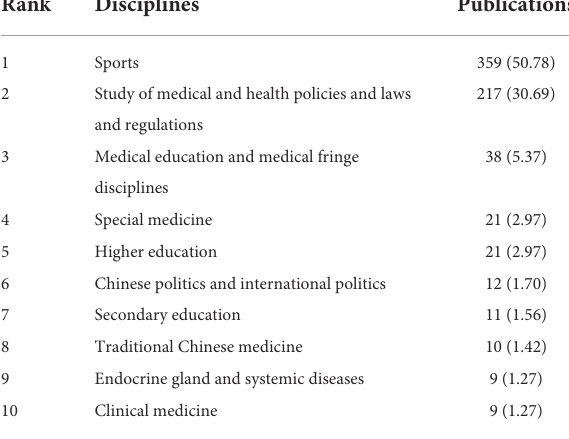
TABLE 1 Discipline distributions of publications on the fusion of sports and medicine in China between 2012 and 2021 [ n (%)].